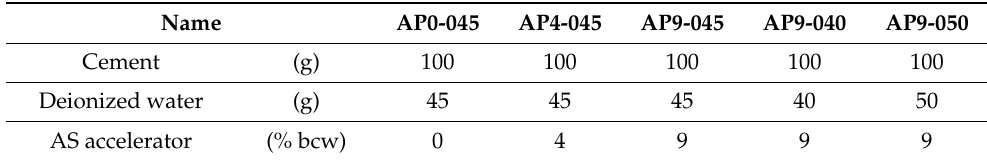
Table 4. Cement paste compositions after adding the AS